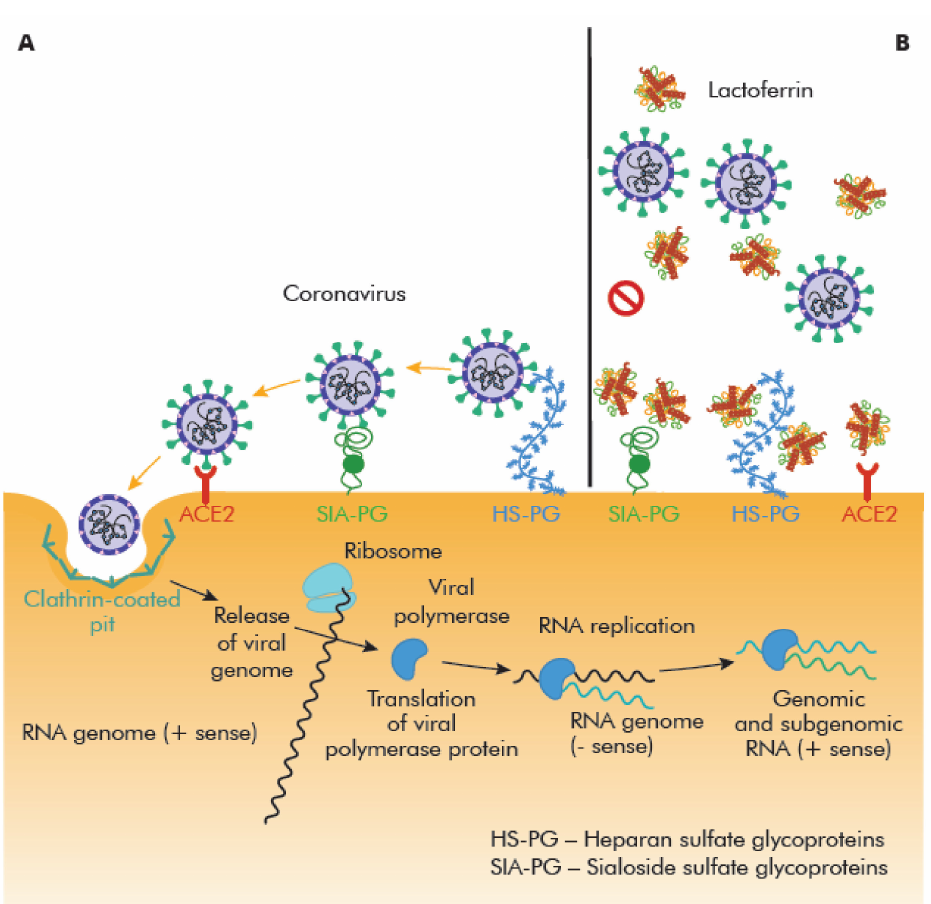
Figure 3. Lactoferrin effects on SARS-CoV-2 docking to cell surface receptors (CSR): Sialoside glycan (SIA) and heparan sulfate (HS). ( A ) SARS-CoV-2 attachment and entry to host cell. SIA and HS chains present on membrane glycoproteins (PGs) facilitate the attachment of the virion to the cell surface. Then the resulting complex binding to the cellular receptor (ACE2), initiating the process of internalization. ( B ) Human lactoferrin was found to exhibit anti-viral activity against SARS-CoV-2 infection, likely mechanisms of action are: Interaction with one of the proteins in the virion envelope S, M, or E, or competition for binding to glycan chains and/or probable the ACE2 receptor